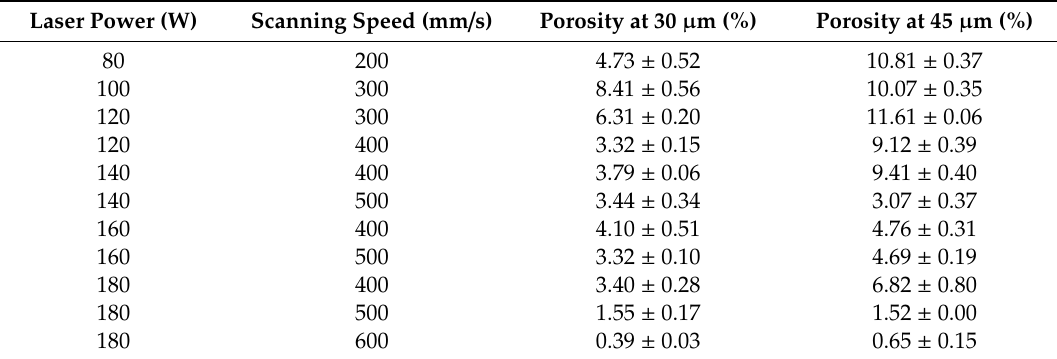
Figure 6. Poor surface finishes for some of the parts built from the 45-µm layer thickness. Table 2. Porosity comparison for the layer thicknesses studied.